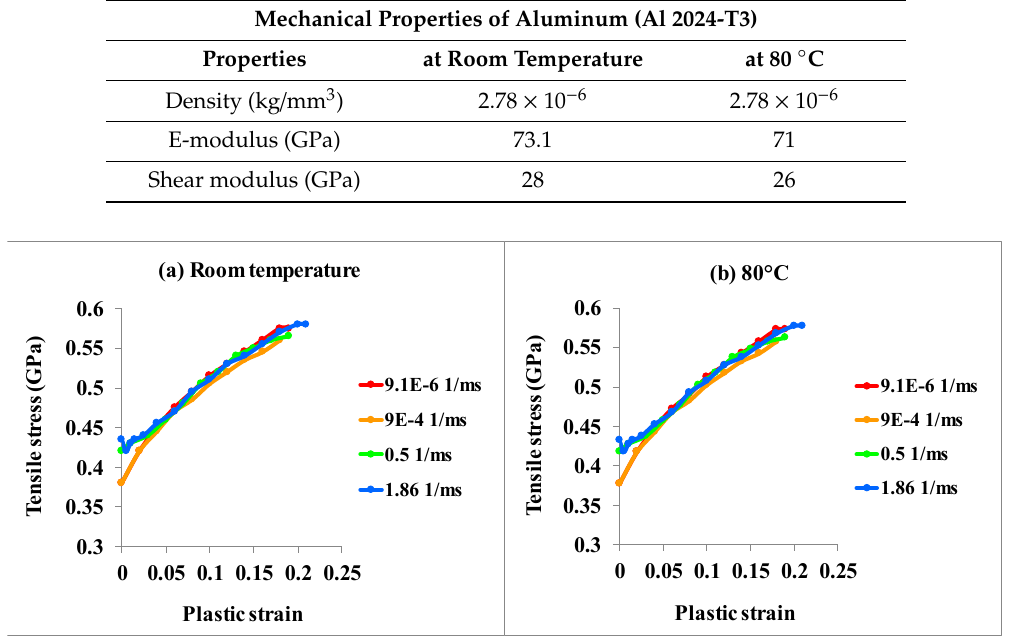
Figure 3. Plastic response of Al 2024-T3 at different temperatures and strain rates [50]. Table 3. Material properties of a cohesive